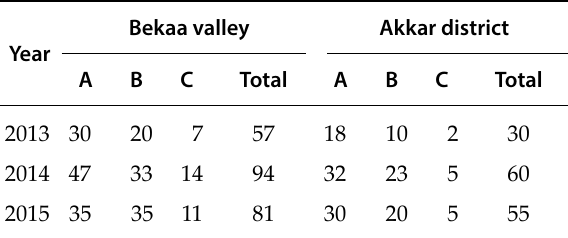
Table 2. Distribution and structure of selected potato fields in 2013-2015 a